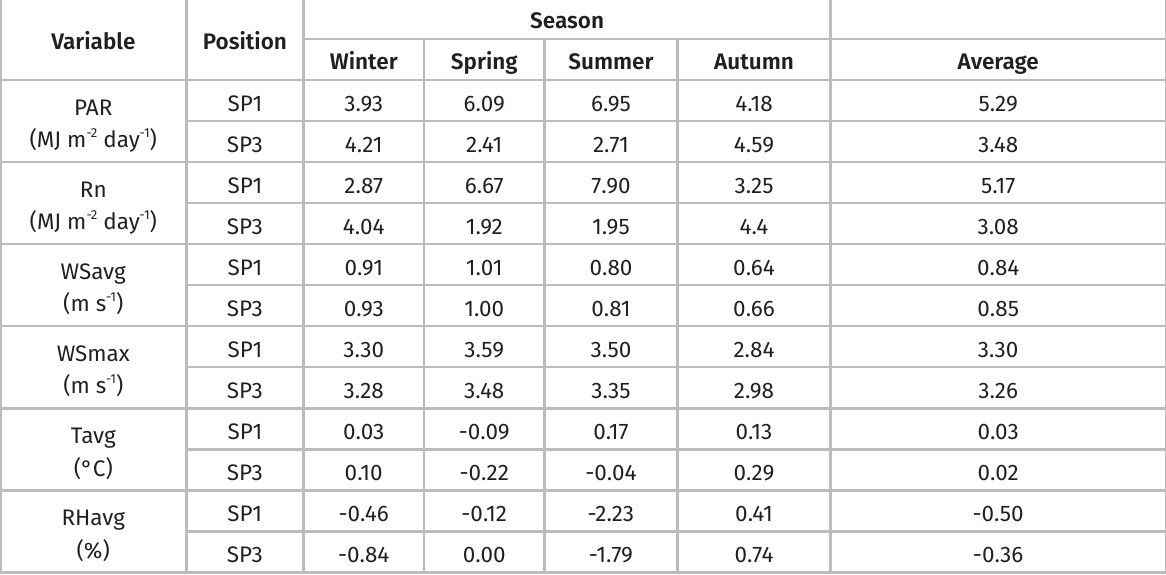
Table III. Mean reductions of photosynthetically active radiation (PAR), net radiation (Rn), average wind speed (WSavg), maximum wind speed (WSmax), average air temperature (Tavg) and average relative air humidity (RHavg), every season, at 0.00 m (SP1) and 7.50 m (SP3) from the North row, in a silvopastoral system.